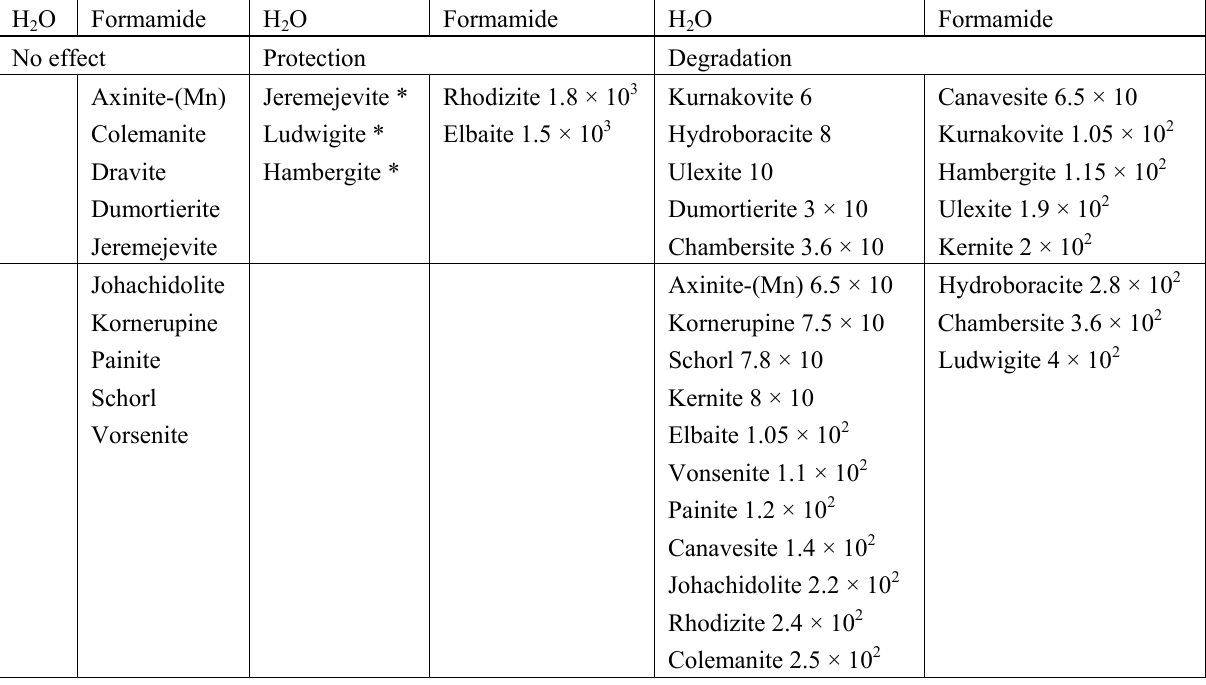
Table 3. The effect of borate minerals on RNA in water and in formamide.